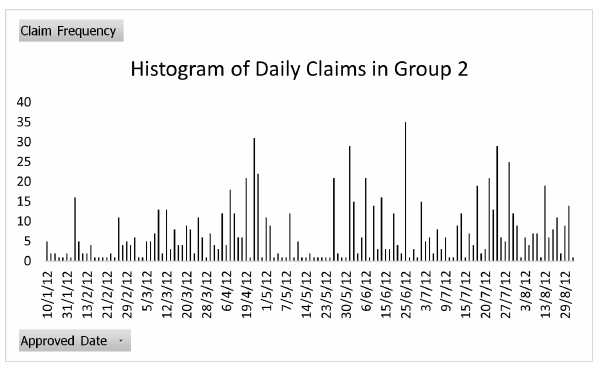
Figure 4. Histogram of Numbers of Claim Payments in Group 2.